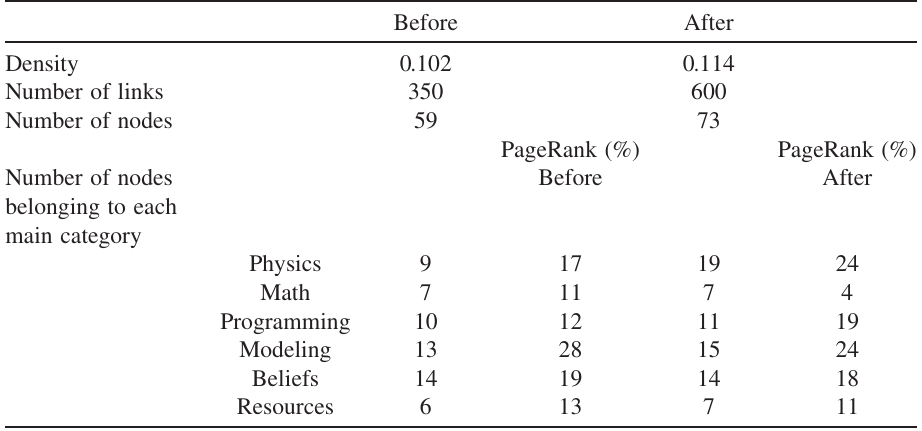
TABLE II. Comparison of the before and after epistemic networks. Before